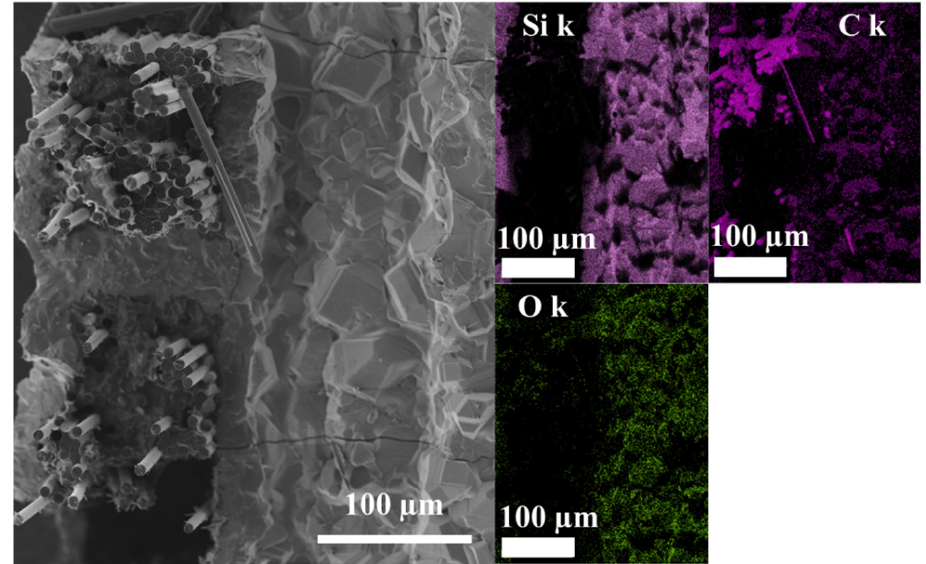
Figure 12. SEM/EDS of a fracture surface showing the presence of SiC, Cf, and